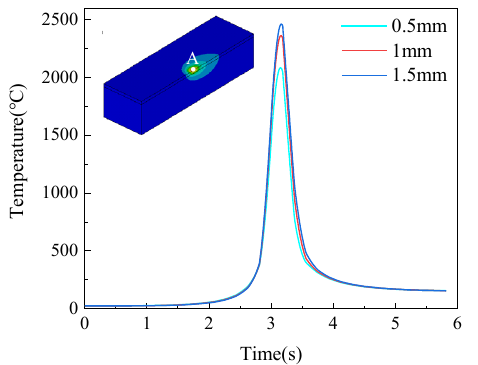
Figure 4. Temperature field variation curves for different coating thicknesses.